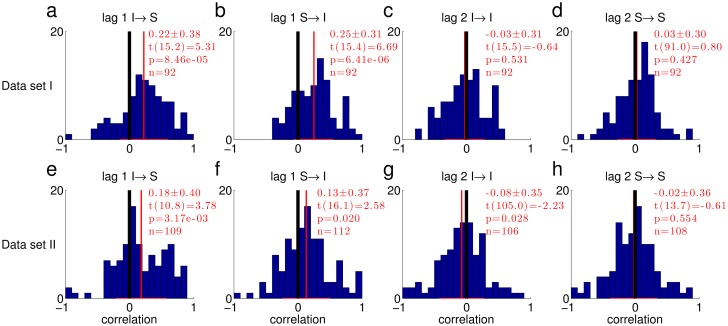
Histograms of correlation coefficients between phase durations in single trials.The transition types are marked above each histogram (for example, I→S denotes transitions from integration to segregation). The mean and standard deviation are indicated in red in each panel, followed by the t-statistic of the fixed effect, its significance and the number of trials for which it was possible to calculate the correlation. The black vertical lines mark zero correlation, and the red vertical lines mark the mean of each distribution. (a-d) Data Set I. (e-h) Data Set II.